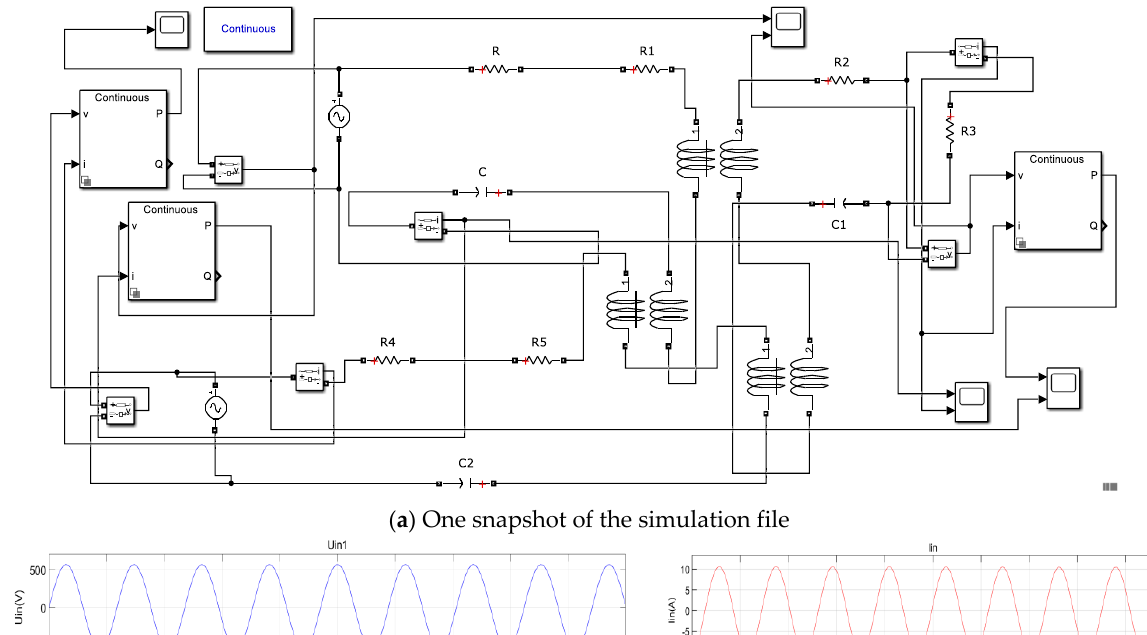
Table 2. Comparison of simulation and theoretical values of output power.